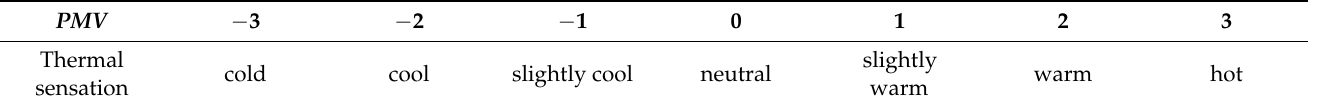
Table 2. Thermal sensation scale of the PMV